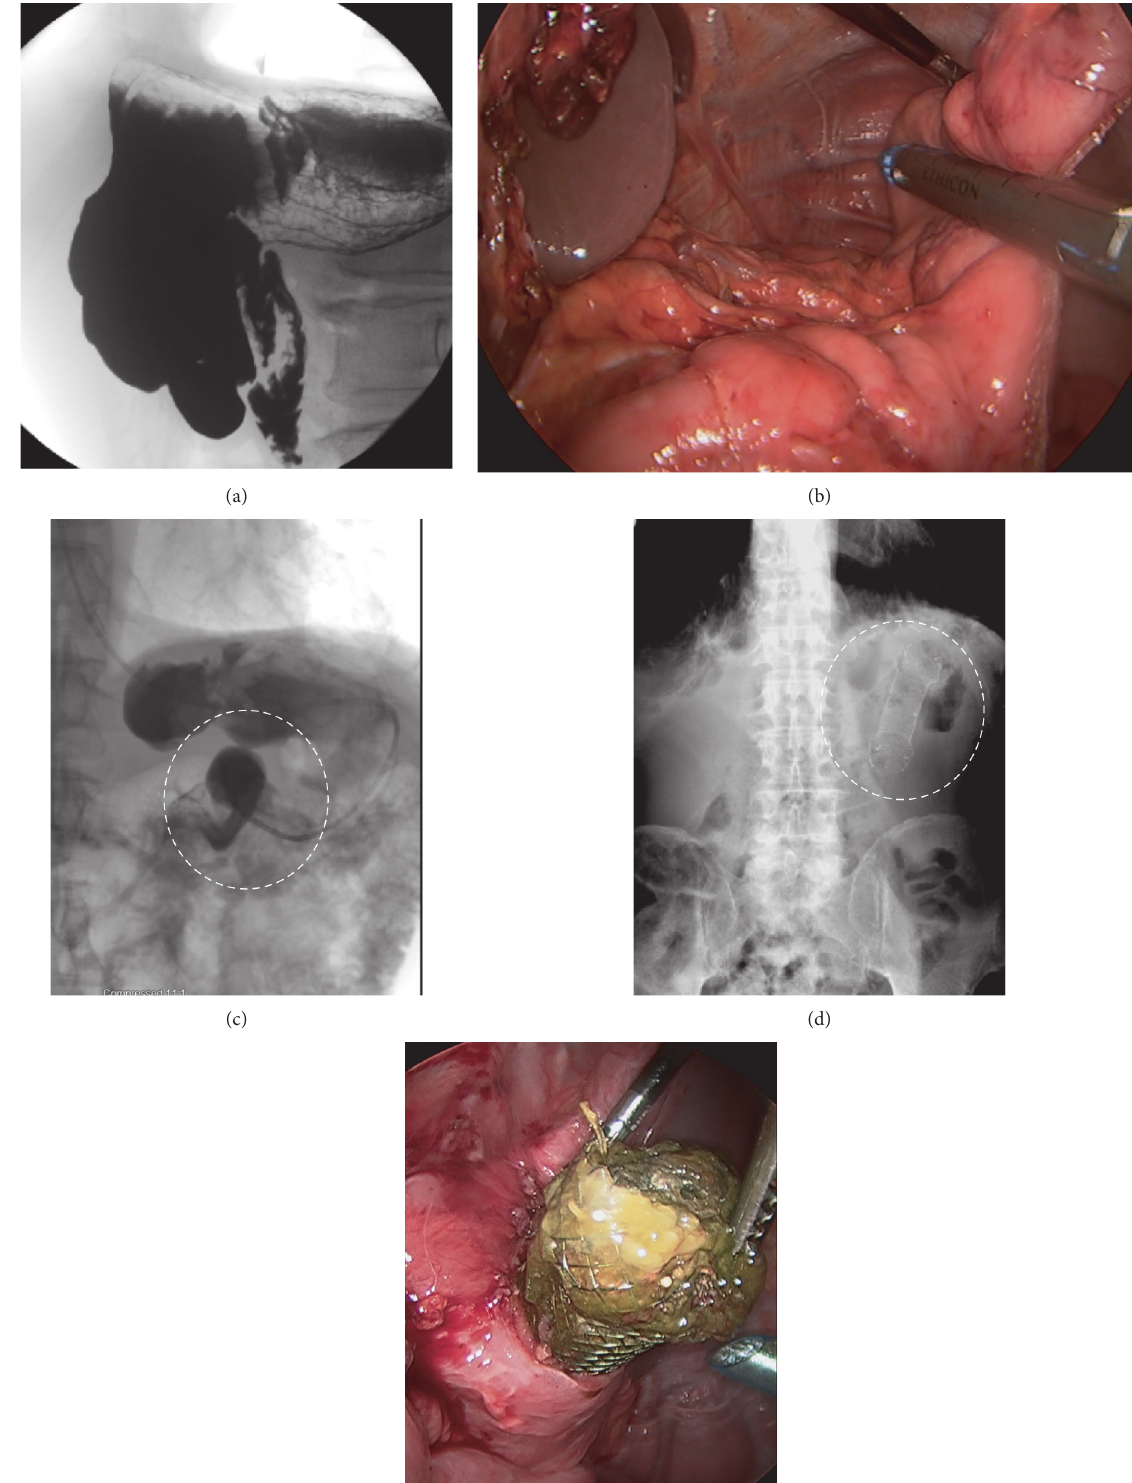
Figure 3: (a) Barium swallow: organoaxial gastric volvulus. (b) Laparoscopy: longitudinal gastrectomy with a very long staple line. (c) Fluoroscopy: alpha-loop in the distal stomach. (d) Abdominal plain film: the stent migrated into the proximal jejunum and is seen in the left upper quadrant. (e) Laparoscopy: the jejunum is opened, and the migrated stent is